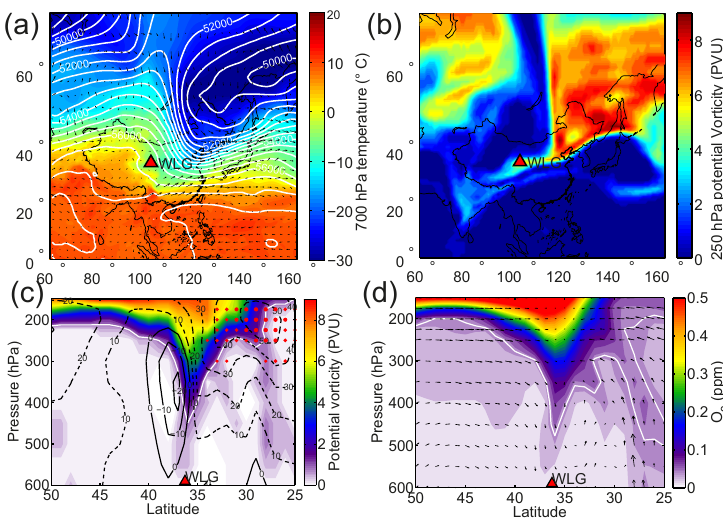
Figure 12. (a) Map of 500hPa geopotential height (white contours), 700hPa temperature (shading), and wind field (black arrows). (b) Map of 250hPa potential vorticity; (c) the cross section of potential vorticity along the 101.0 ◦ E longitude line. The white line denotes the 1 PVU isoline, the black lines are U wind isolines (dashed lines for westerly winds and solid lines for easterly winds), and the red dots indicate the location of the subtropical jet stream ( U wind > 35ms − 1 ) . (d) The cross section of ozone mixing ratios, V wind, and W wind vector along the 101.0 ◦ E longitude line from the ECMWF reanalysis during an STT transport event on 30 March 2012. The white line denotes the 50ppbv ozone contour.